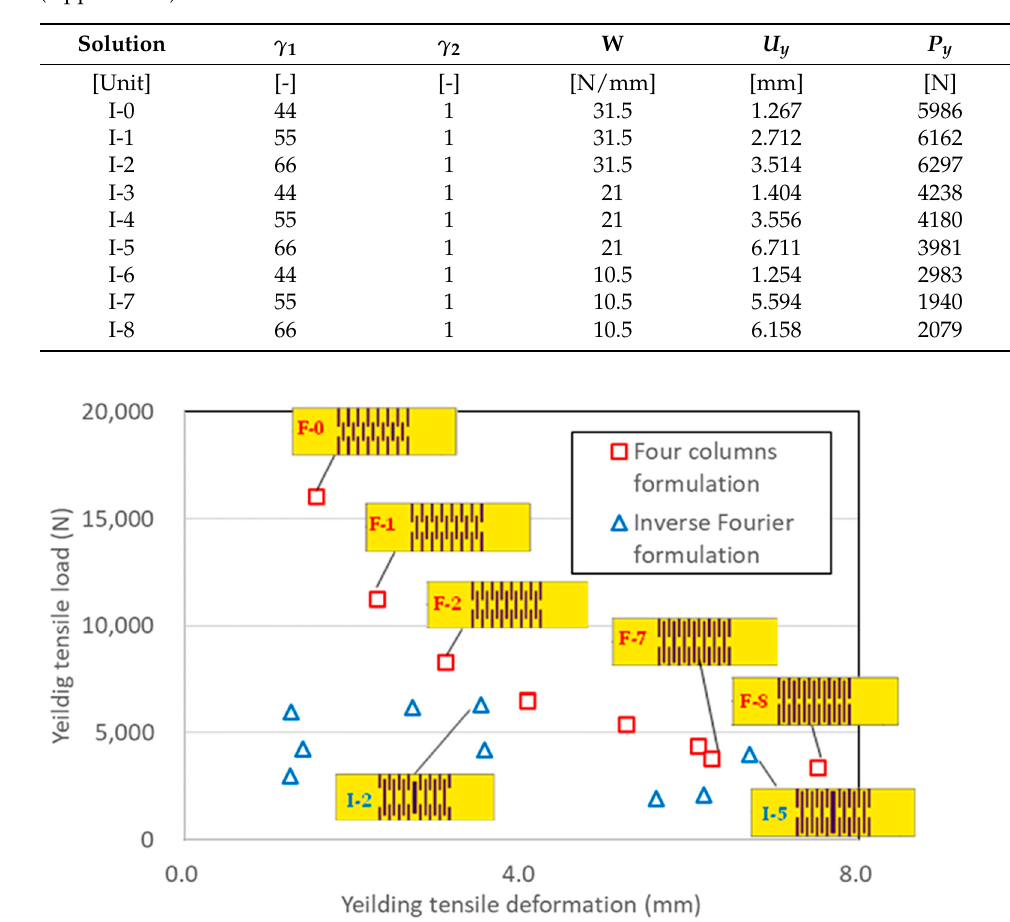
Figure 3. Relationship between tensile yielding deformation and tensile yielding